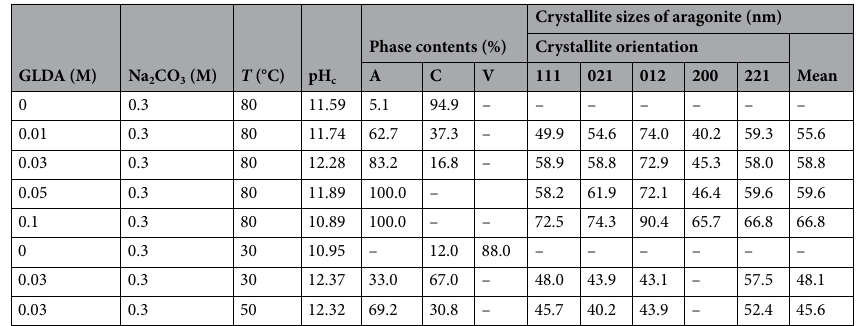
Table 3. Effects of carbonation conditions on the selected properties of CaCO 3 particles. A: aragonite, C: calcite, V: vaterite